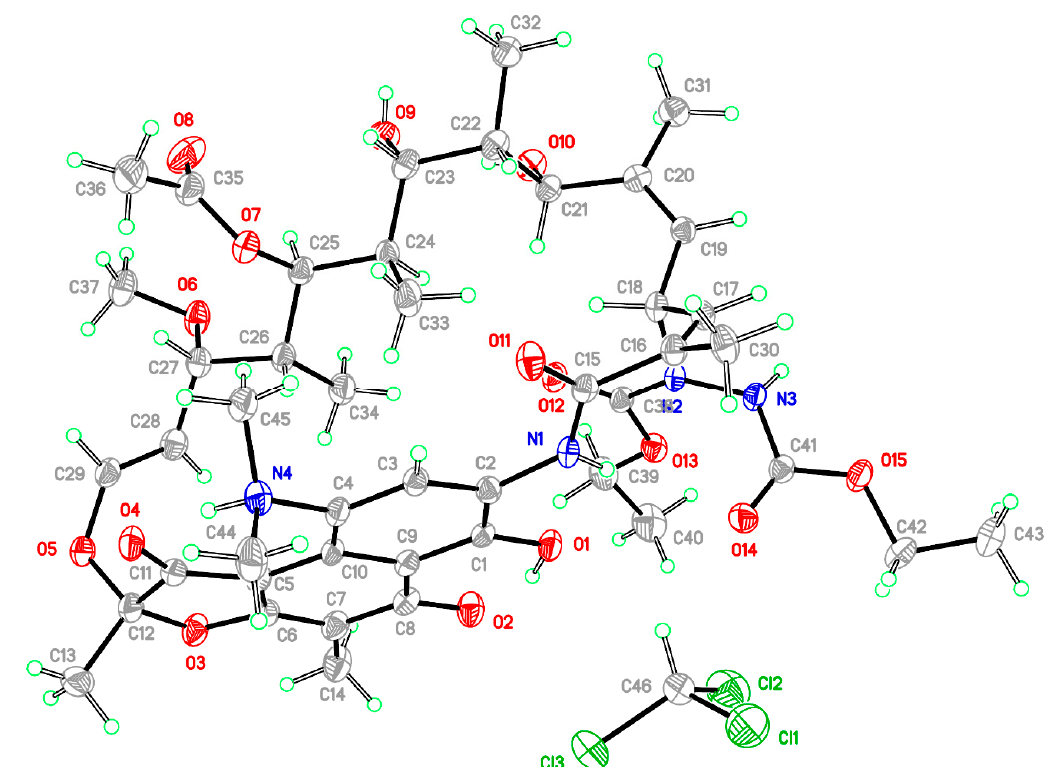
Figure 1. A view of the asymmetric unit of the crystal structure showing the atom numbering scheme employed. In this figure, the structure is viewed obliquely from below the naphthalene ring. Anisotropic atomic displacement ellipsoids for the non-hydrogen atoms are shown at the 50% probability level. Hydrogen atoms are displayed with an arbitrary small radius.